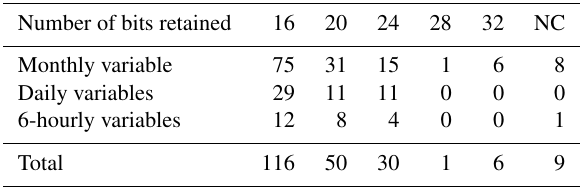
Table 2. The number of variables that used each fpzip compression level (in terms of number of bits retained). Note that NC means “not compressed” due to missing